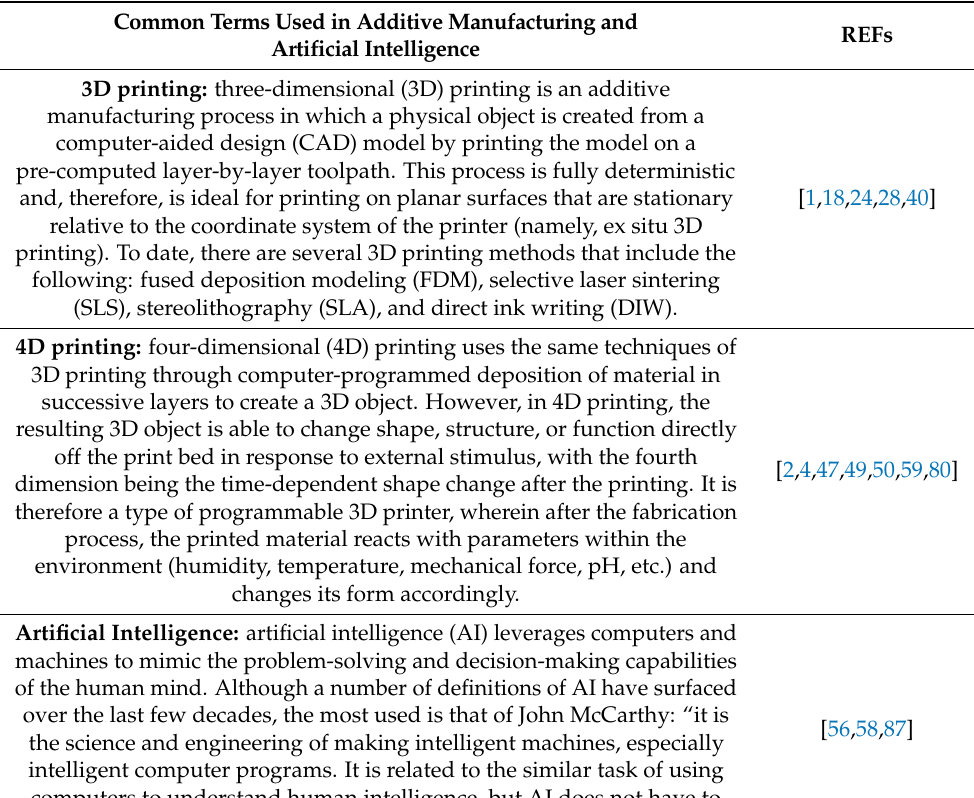
Table 1. Definition of common terms used in AM and